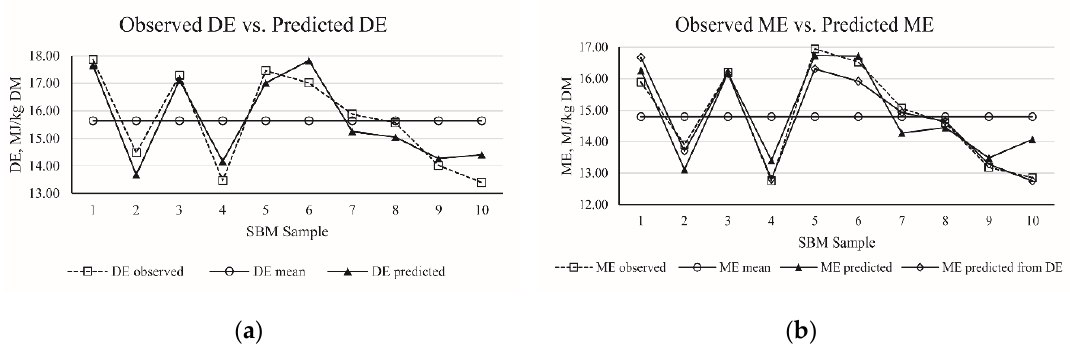
Figure 2. ( a ) The distribution of observed digestible energy (DE) of soybean meal (SBM) and predicted DE of SBM calculated from best-fit equation in present study; ( b ) the distribution of observed metabolism energy (ME) of SBM, predicted ME of SBM from DE, and predicted ME of SBM calculated from the best-fit equation in present study.